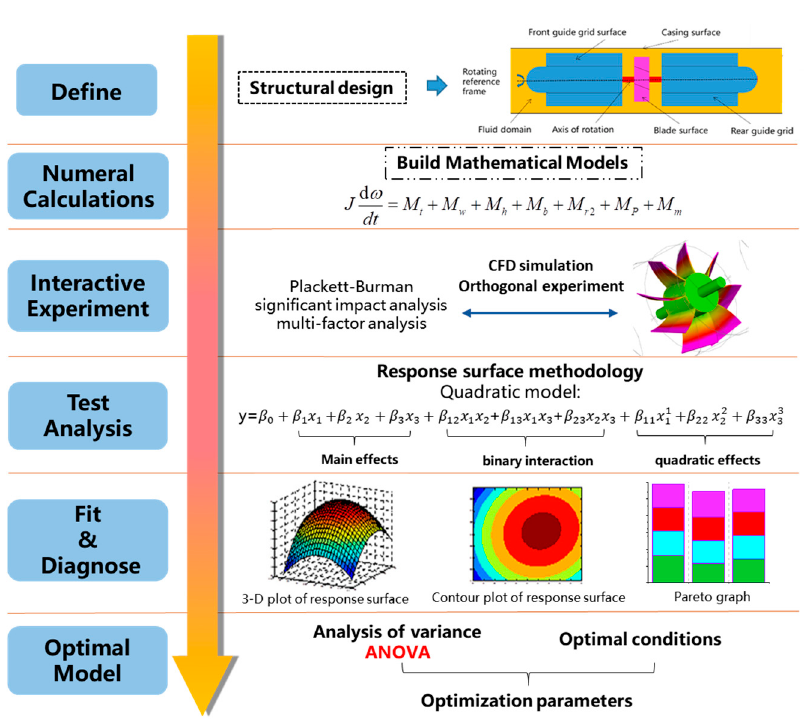
Figure 4. Flow chart of optimization design analysis. Table 1. Influencing factors and horizontal parameter values.